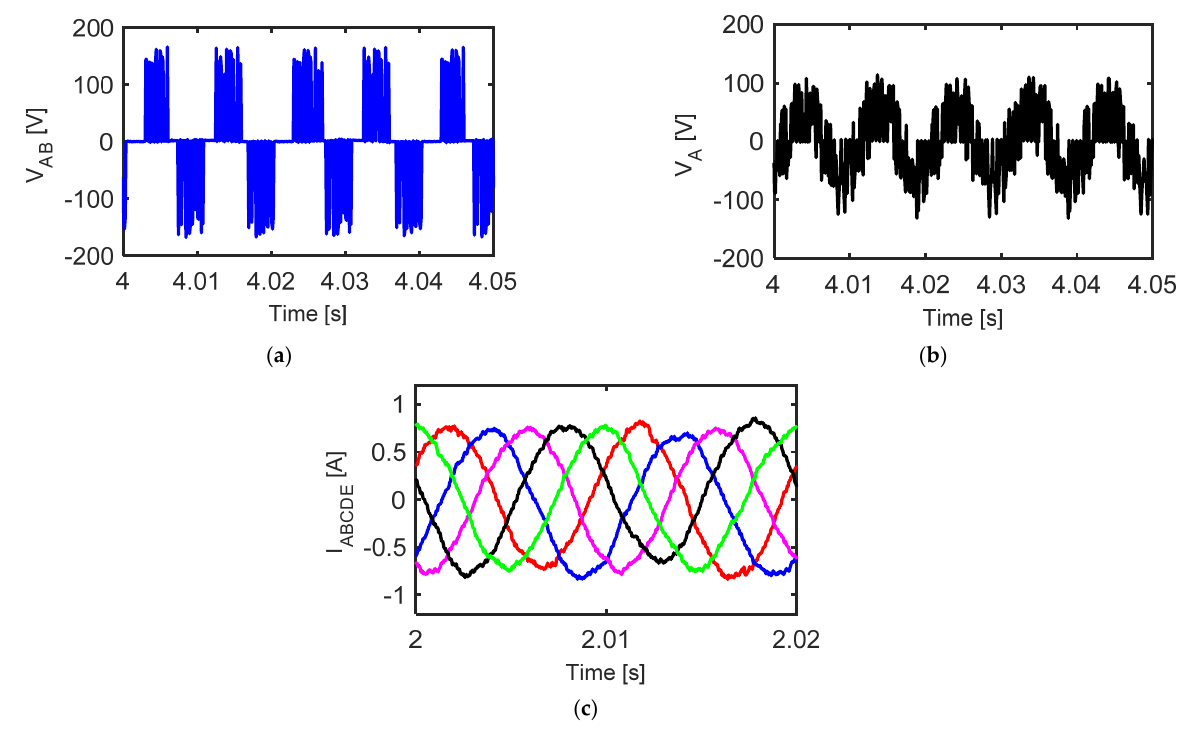
Figure 17. Experimental results at 100 Hz output frequency ( a ) output line voltage, ( b ) output phase voltage and ( c ) output phase currents.